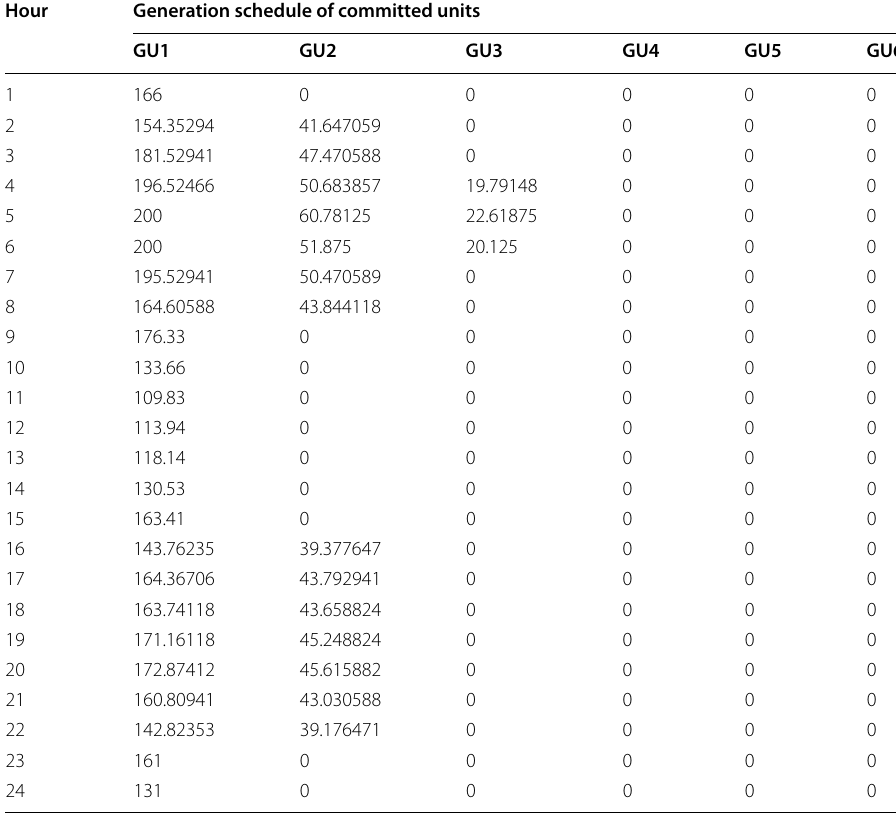
Table 3 Power scheduling for 6-generating unit system considering renewable energy in